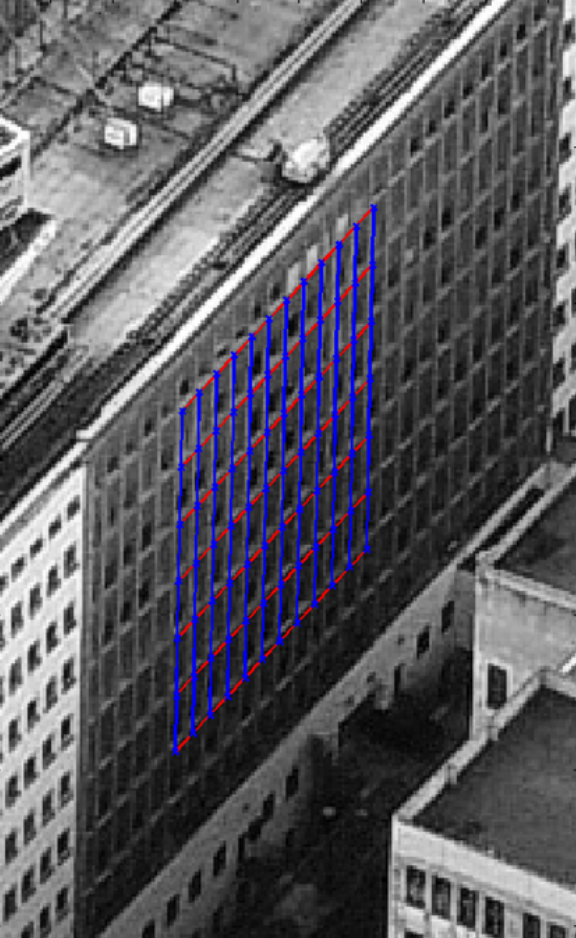
Figure 9: Result of lattice extraction in oblique optical image. The red vector correspond to the horizontal, the blue to the verti- cal alignment of the lattice